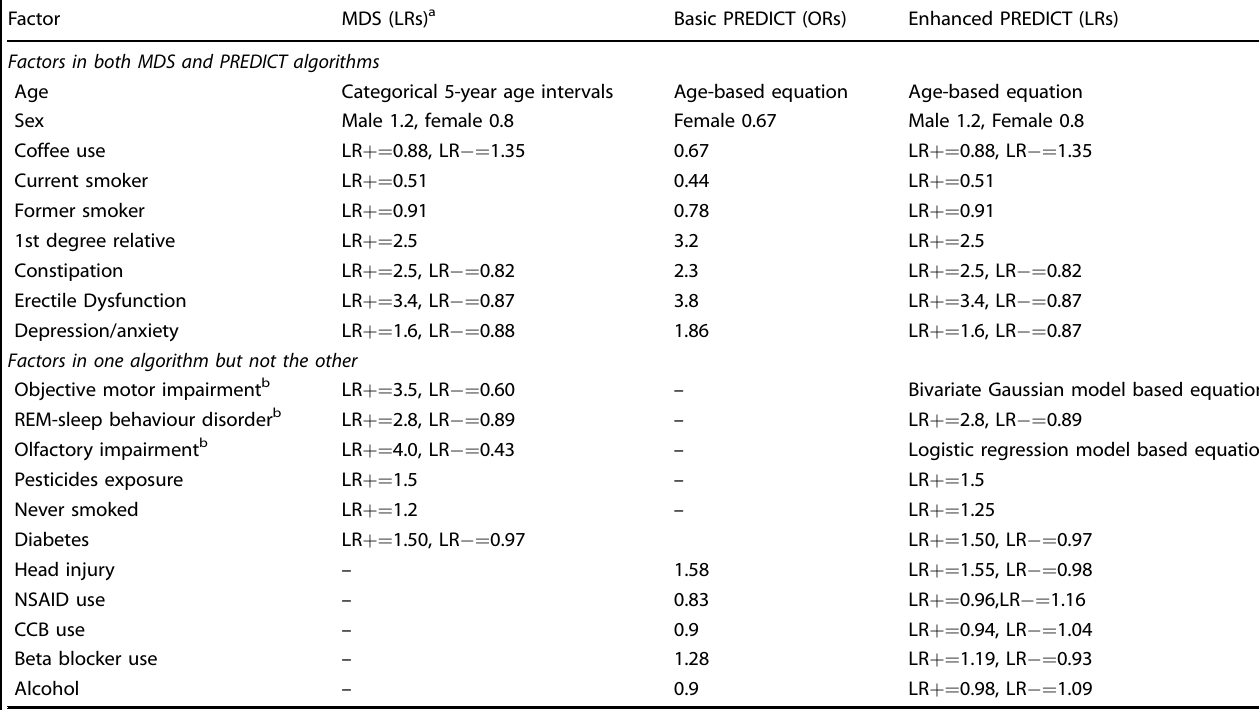
Table 2. Likelihood ratios (LRs) and odds ratios (ORs) for PD risk factors collected in the PREDICT-PD pilot cohort using the PREDICT-PD risk algorithms and MDS prodromal criteria.